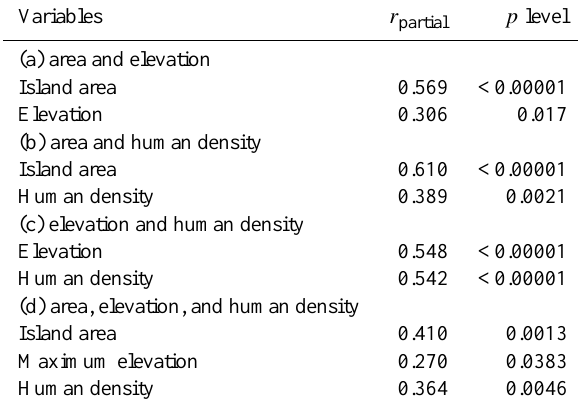
Table 1. Partial correlations between tenebrionid richness (depen- dent variable) and island area, maximum elevation, and human pop- ulation density (independent variables) on the Italian islands. The partial coefficient indicates correlation between the respective vari- able and the dependent variable, after controlling for all other inde- pendent